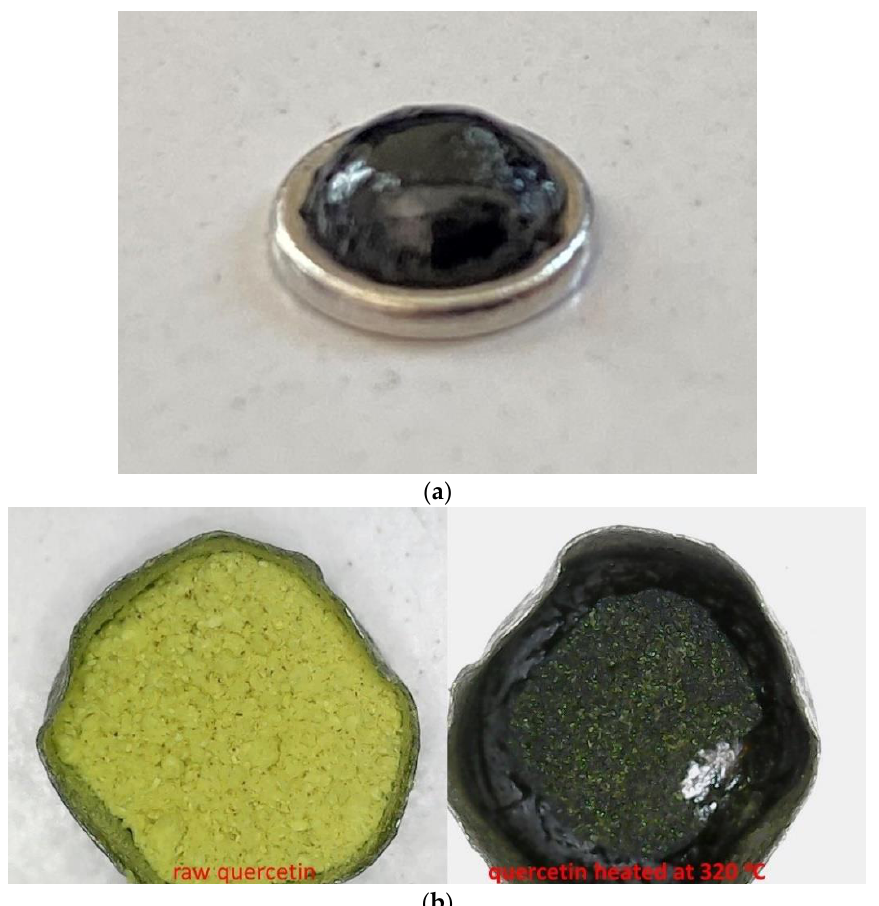
Figure 2. ( a ) Photograph of the DSC pan after the measurement up to 350 °C showing that mass loss out of the pan occurred during the measurement, and ( b ) Photographs from digital microscope of quercetin in the TGA pan before and after being heated at 320 °C.